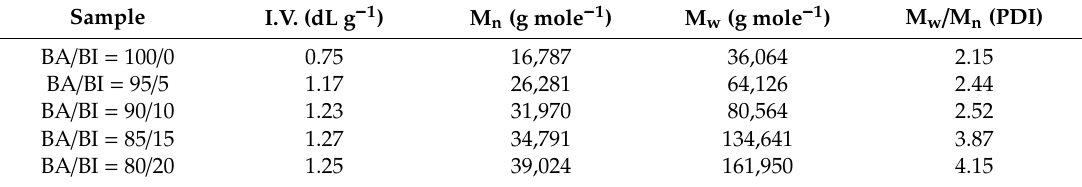
Table 1. Gel permeation chromatography (GPC) results and the I.V. values of PBABI